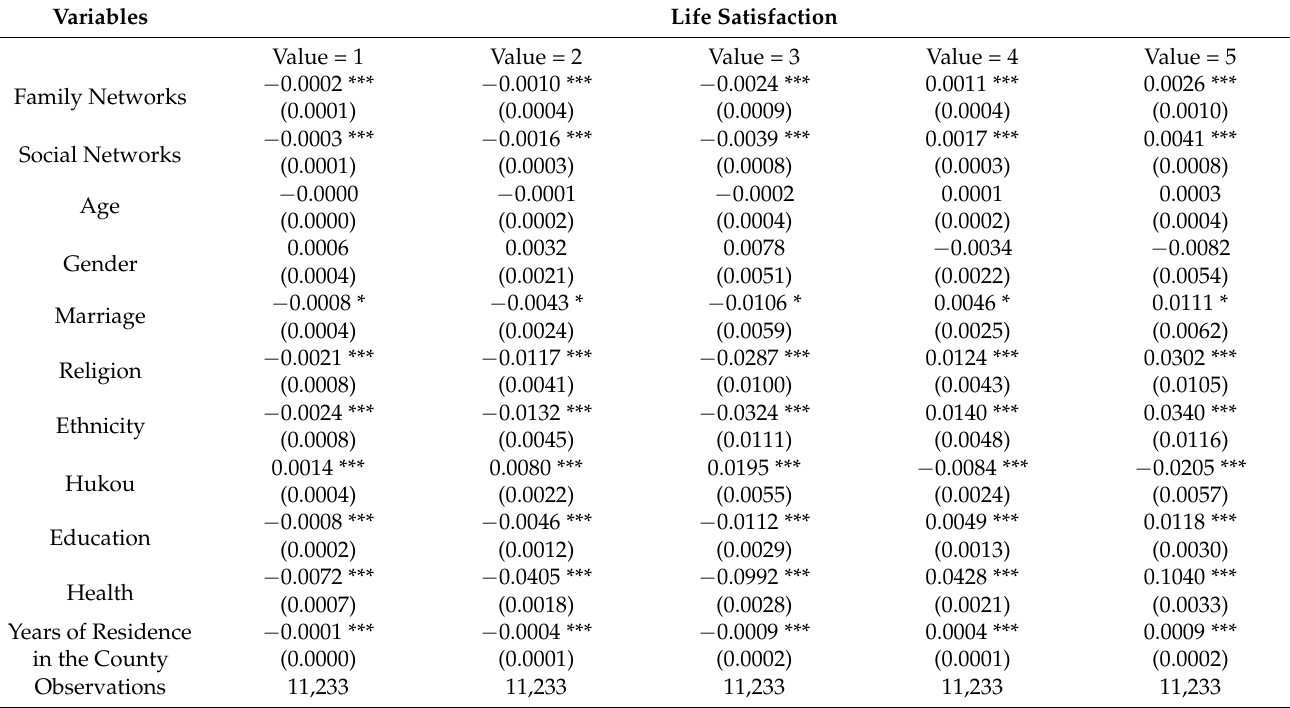
Table 4. Robustness test: marginal treatment effect of ordinal logistic